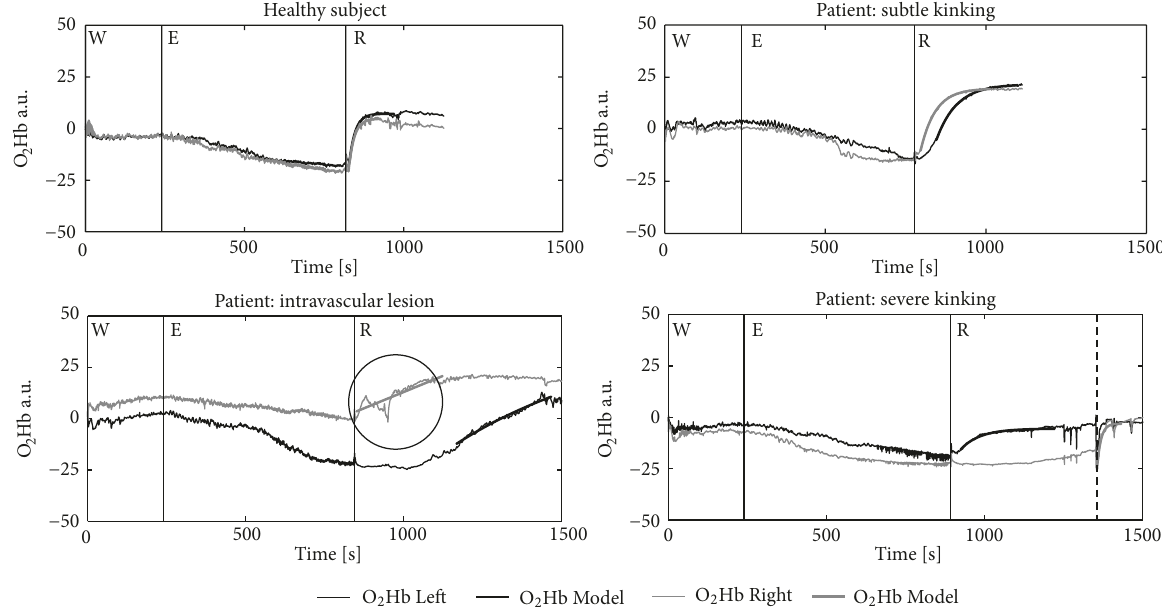
Figure 5: O 2 Hb patterns of the left (black) and right (red) leg in CP during warm-up (W), RAMP exercise protocol (E), and recovery (R); solid vertical lines denote phase transitions. The dashed line in CP with severe kinking represents the sudden change from CP to NP to demonstrate the effect of severe kinking on oxygenation. The data within the black solid circle in the patient with an intravascular lesion shows inaccurate data due to movement artefacts of the patients’ right leg which slipped of the resting